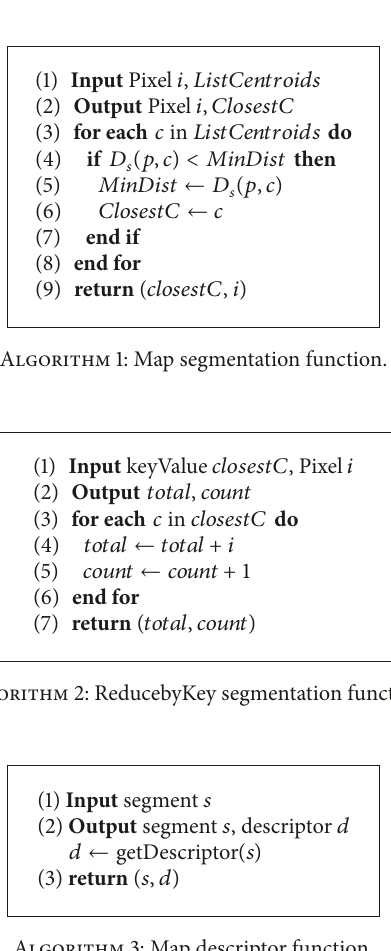
Algorithm 3: Map descriptor function.